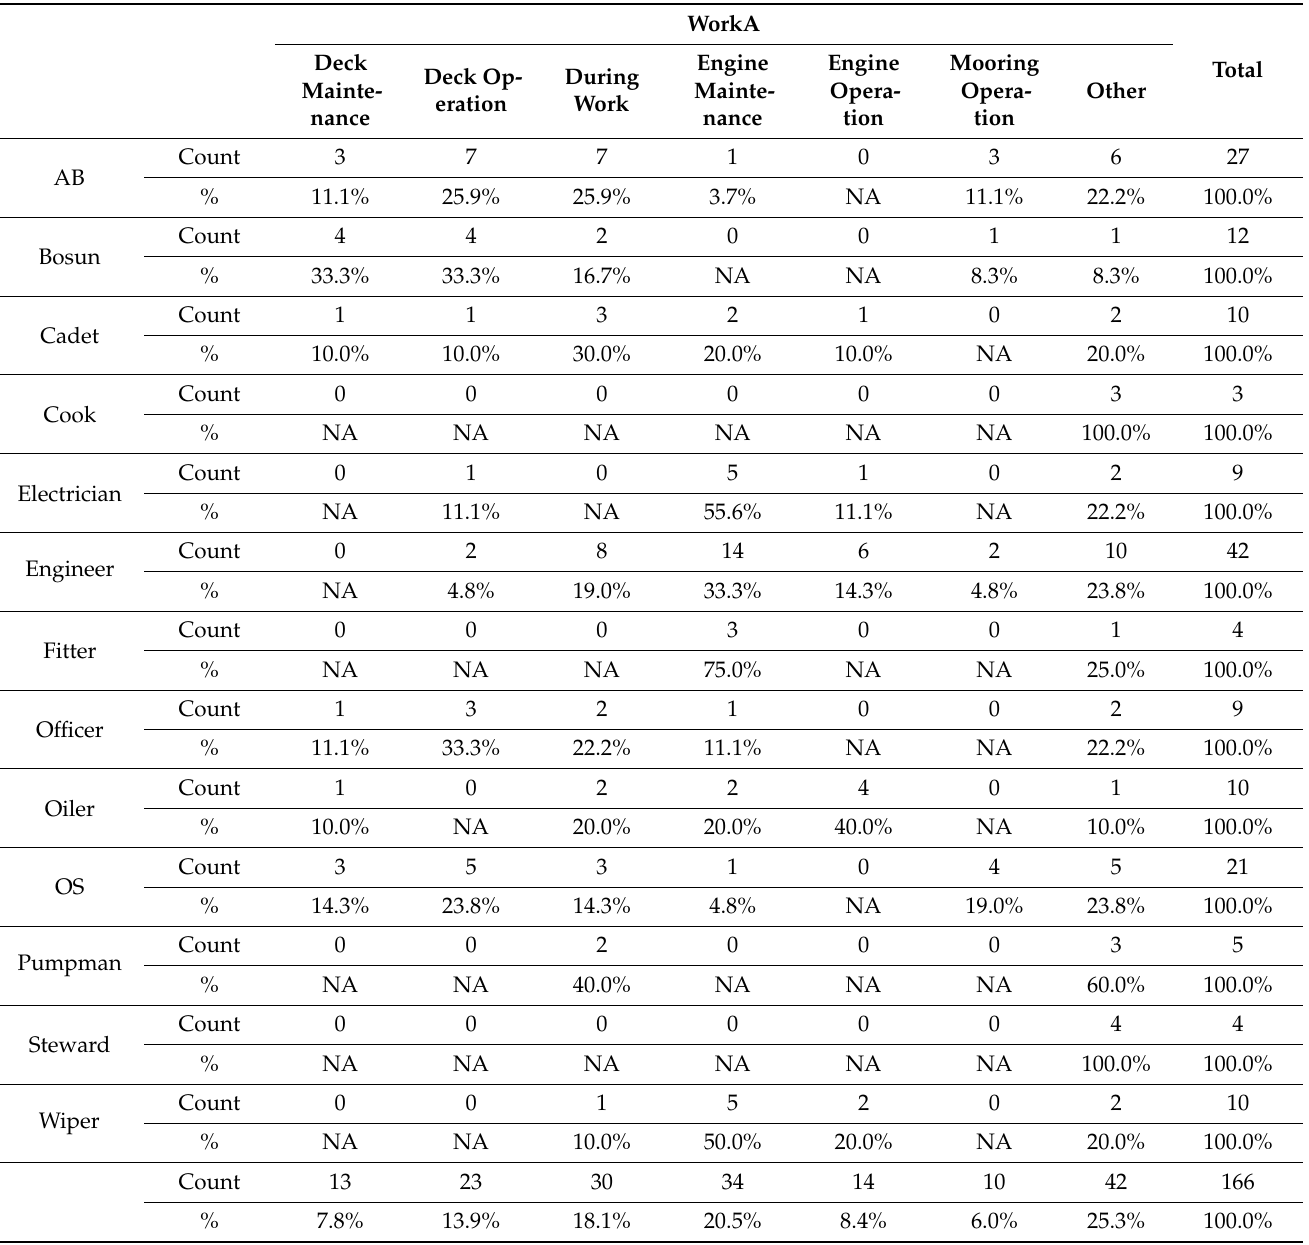
Table 4. Cross tab